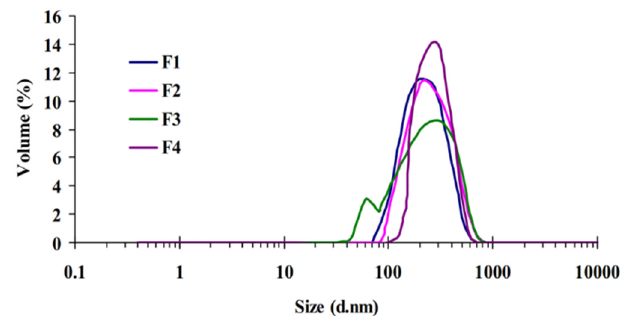
Figure 1. Particle size distribution of gliclazide-loaded nanoparticles.